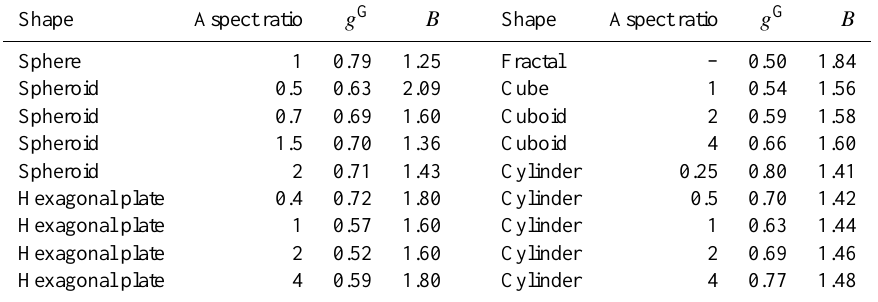
and λ 2 are the specific wavelengths used in the algorithm k e k e